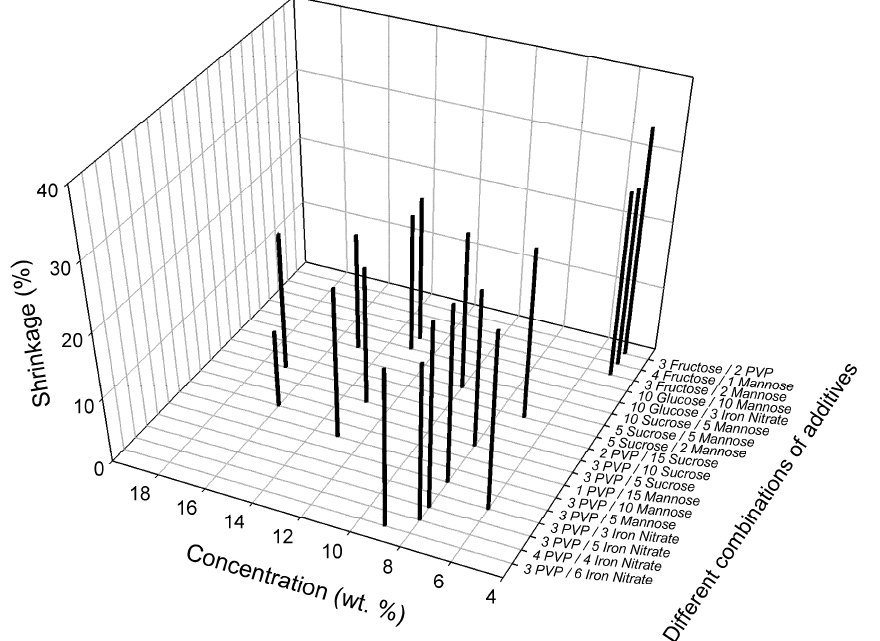
Figure A5. Combination of different additives (after deacetylation) effecting the shrinkage of dried cellulose fibers.